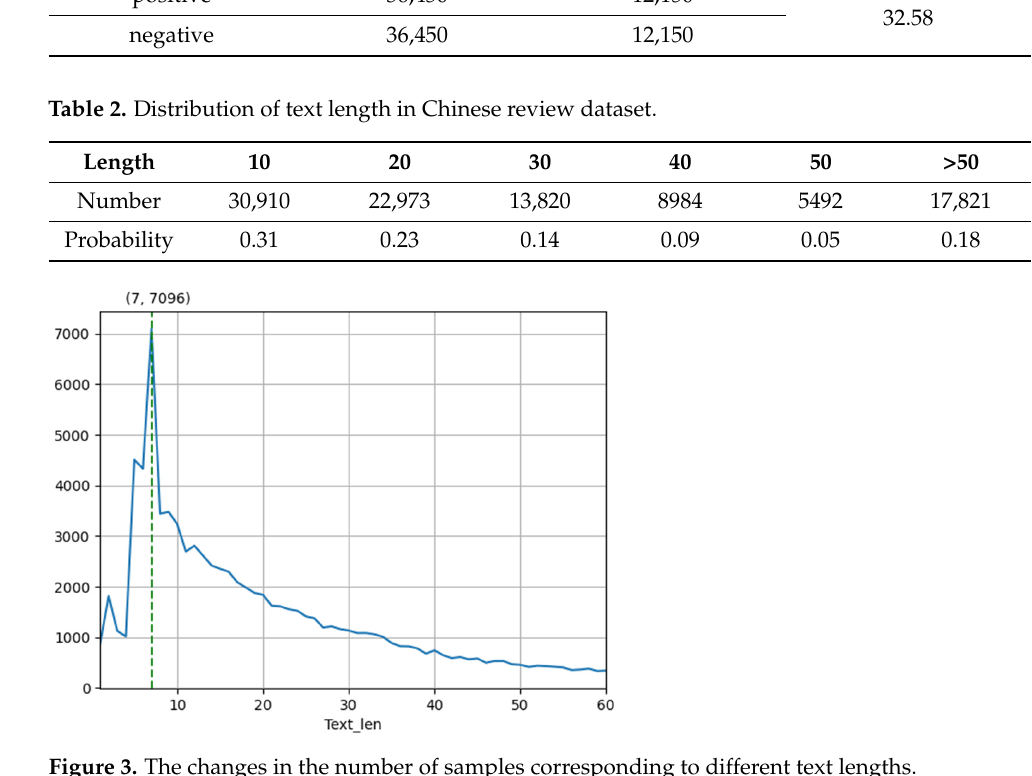
Figure 3. The changes in the number of samples corresponding to different text lengths.